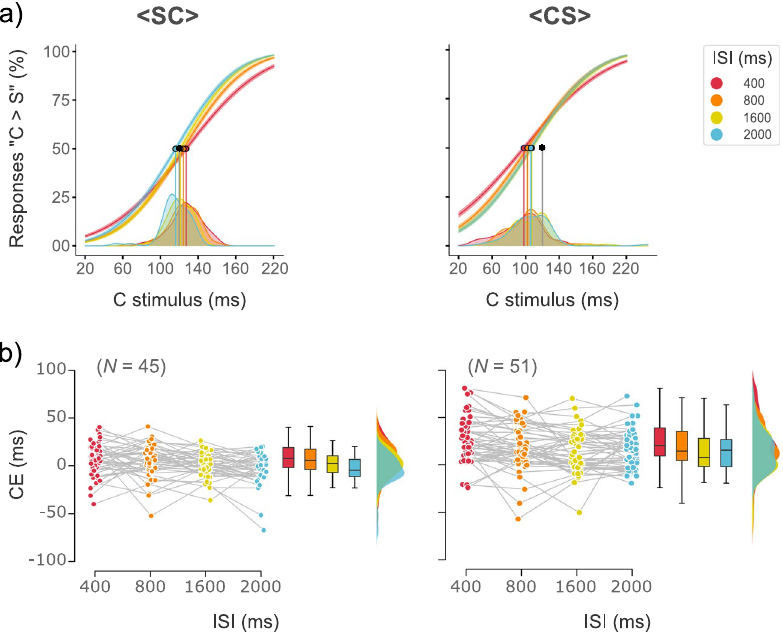
Figure 3. Constant error (CE) of human observers. ( a ) Psychometric curves of human observers. Fitted curves modeling performance of each ISI level for both groups: <SC> and <CS> . The durations of the six C stimuli are plotted on the x -axis and the probability of responding “C longer than S” on the y -axis. Logistic curves depict separate fits for each ISI condition. The gray dot and vertical line depicts the physical magnitude φ s of the S stimulus. The remaining dots and vertical lines represent the point of subjective equality (PSE) for each ISI condition. Density plots show the subject-to-subject variability of the PSE for each ISI level. ( b ) Data points depict individual CEs for both <SC> and <CS> groups at each ISI level. Box-whisker, and density plots show the distribution of the CEs. The median is represented by the horizontal line in the box plots, whereas the bottom and top whiskers depict the IQR. CEs are larger for the <CS> than for the <SC> group. However, for both groups the CE decreases as the ISI increases, with exception of the ISI 2000 condition of the <CS> group. Note that subjects with 3 standard deviations above-below the mean of the CE and slope were discarded.